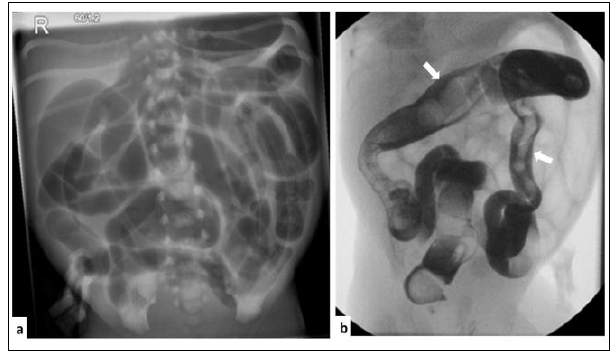
Figure 1: (a) Plain abdominal radiograph of preterm with FIOP showing generalised bowel distension. (b) Meconium plugs, shown as filling defects (arrows) in the non-distended colon and terminal ileum are seen on the contrast enema study. Contrast enema is both diagnostic and